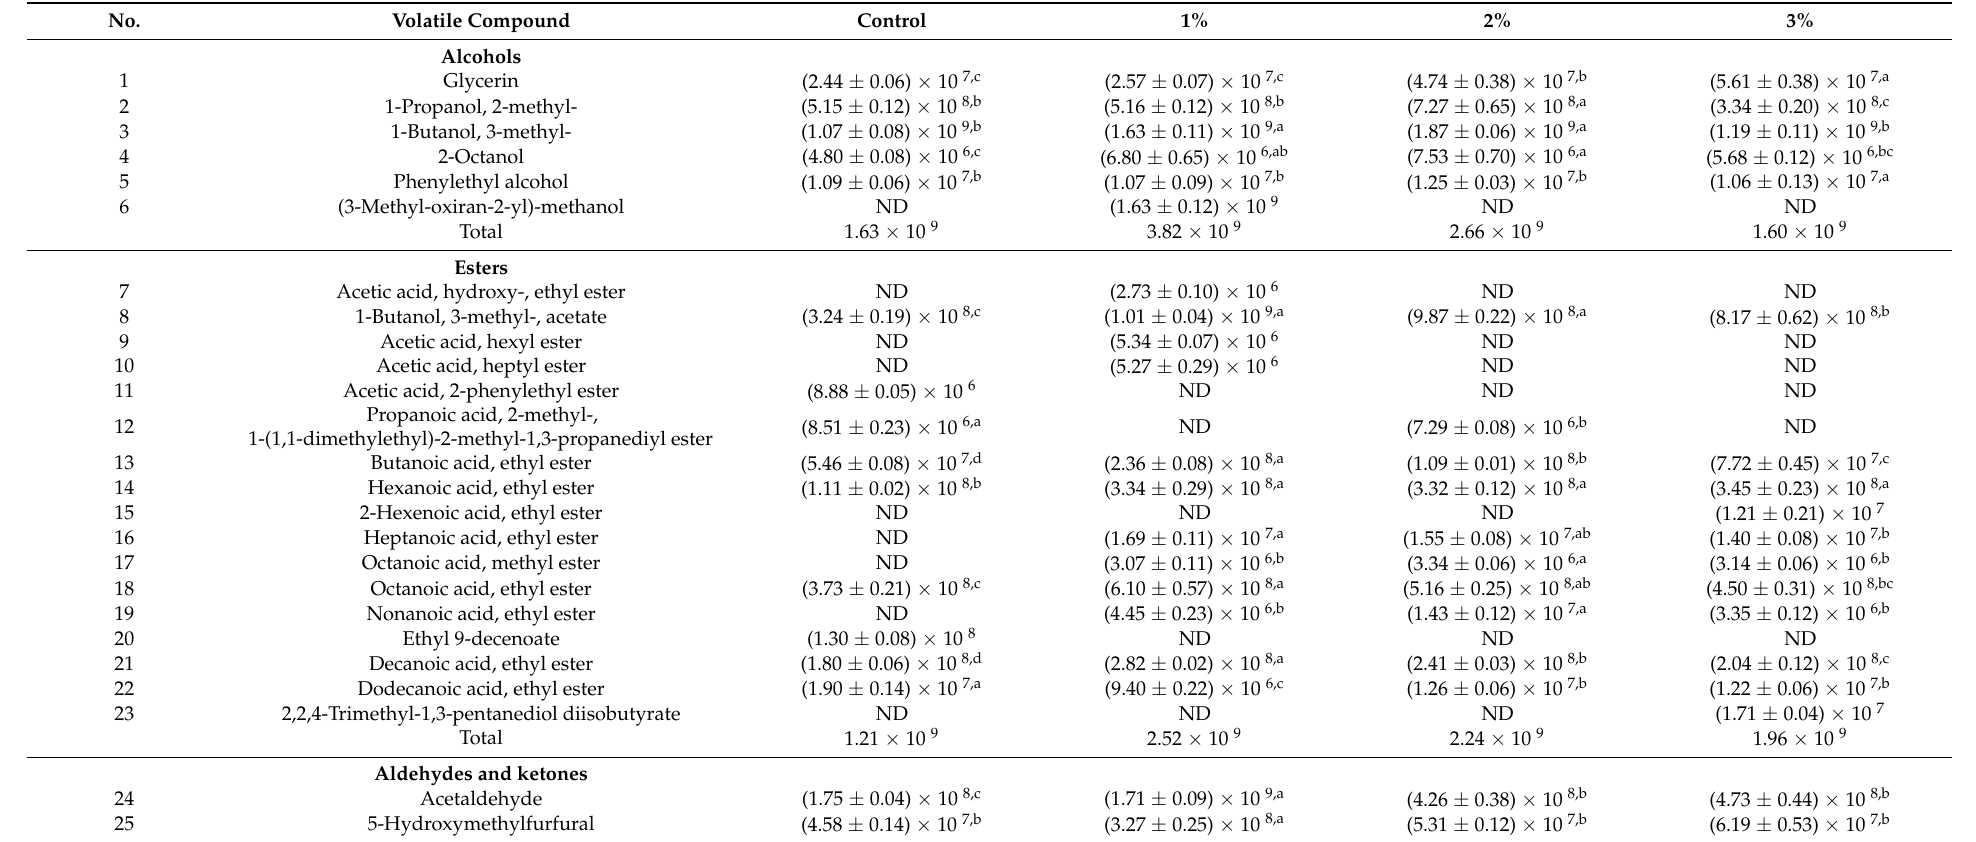
Table 5. Relative amounts of volatile compounds in the four mulberry fermented alcoholic beverages with different amounts of mulberry leaf powder after